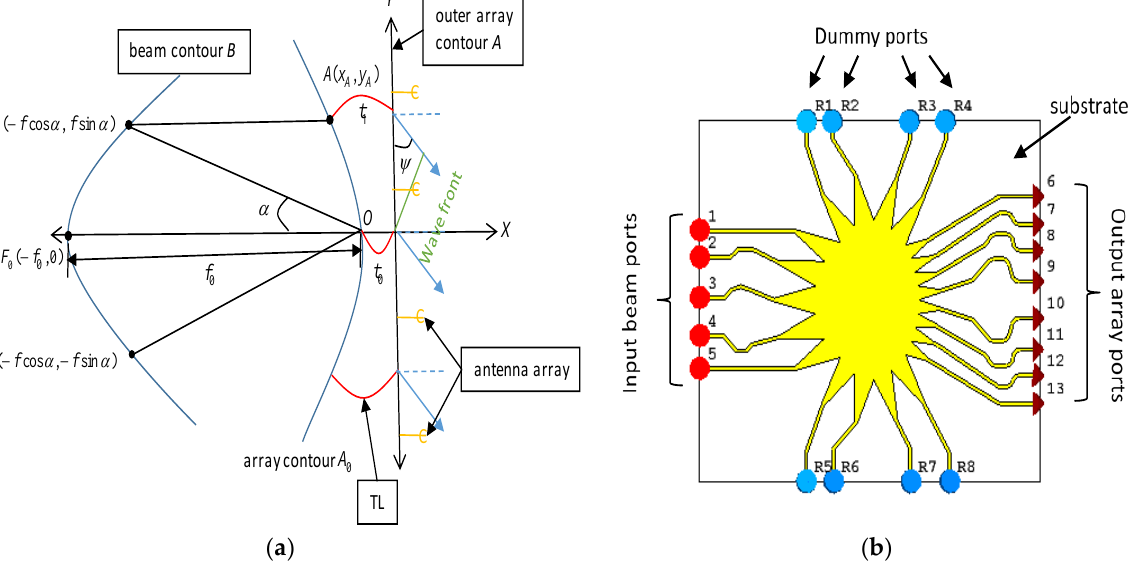
Figure 1. ( a ) Typical Rotman lens contours; ( b ) Rotman lens design with 5 input beam ports and 8 output array ports.